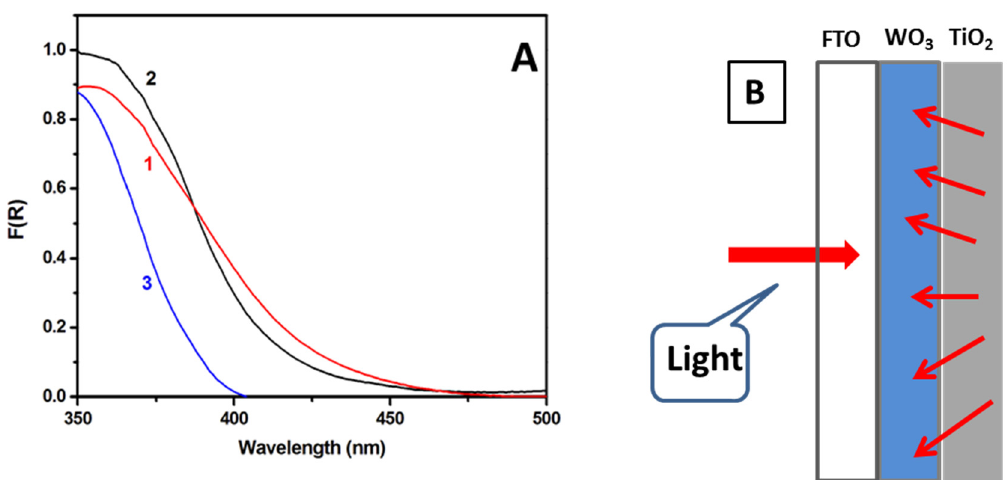
Figure 3. ( A ) Reflection-absorption spectra of the WO 3 (1) and the TiO 2 /WO 3 (2,3) photoanode. Curve 3 was obtained by front side reflection and Curve 2 by reflection through the supporting FTO glass. Curve 3 is typical of the nanoparticulate titania absorption spectrum. ( B ) Graphical representation of the direction of photons in the presently used setup.